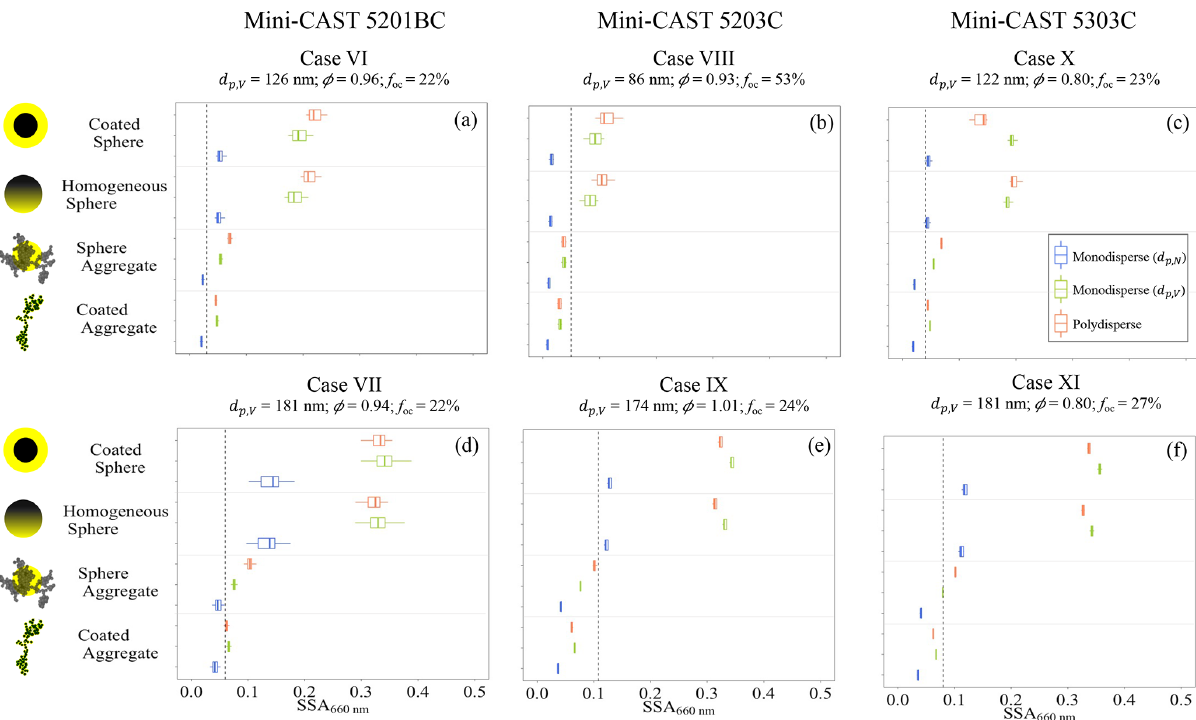
Figure 10. Modelled SSA at a wavelength of 660nm from various cases of miniCAST generators in E2, summarized in Table 1. The = 126nm (a) , miniCAST 5201BC d = 181nm (d) , miniCAST 5203C d = 86nm (b) , results are shown for miniCAST 5201BC d p ,V p ,V p ,V = 174nm (e) , miniCAST 5303C d = 122nm (c) , miniCAST 5303C d = 181nm (f) . In each panel, the SSA miniCAST 5203C d p ,V p ,V p ,V is modelled using four coated BC representations: “coated sphere”, “homogeneously mixed sphere”, “coated aggregate”, and “aggregate and sphere”. Further, for each representation, the SSA is modelled using monodisperse and polydisperse methods. The mean of the experimentally measured SSA is shown by the black dashed line in each